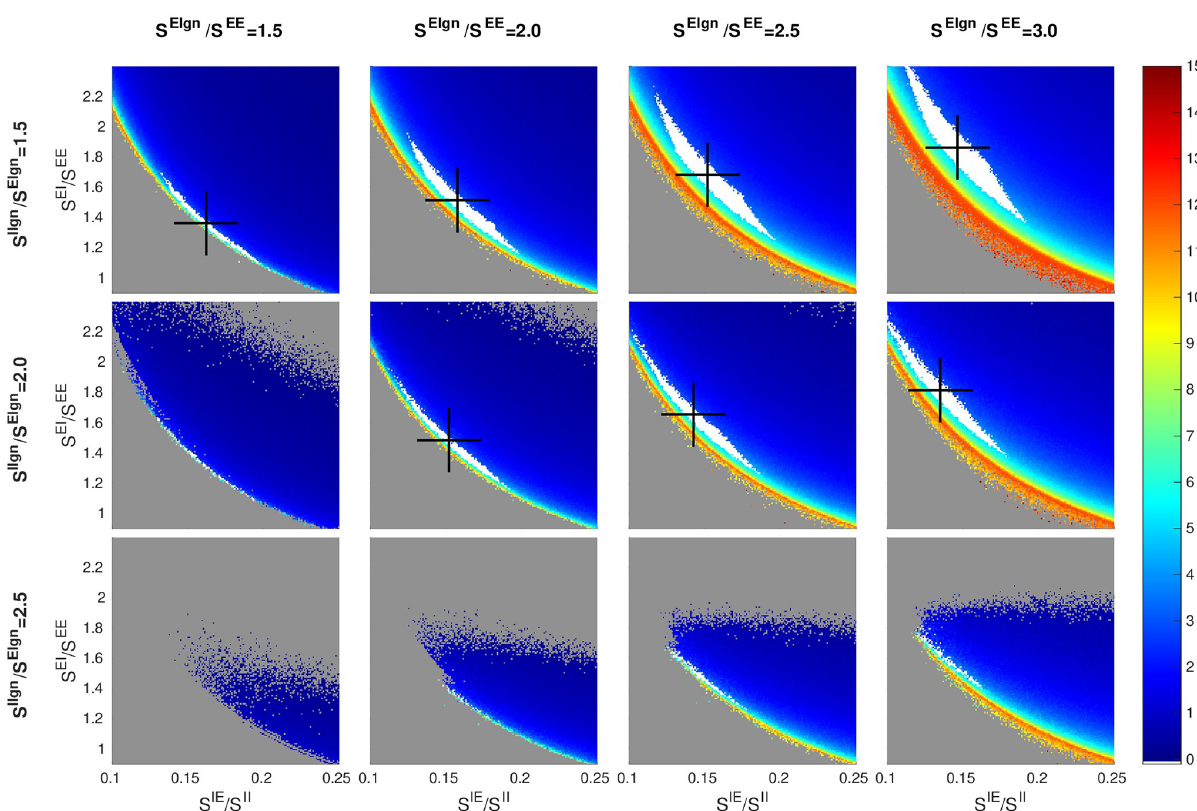
Fig 2. Dependence of firing rate and good area on LGN synaptic strengths. A 3 × 4 matrix of panels is shown: each row corresponds to a fixed value on an inhibition plane (color bar on the right); x and y -axes of S I lgn / E lgn and each column a fixed value of S E lgn / S EE . Each panel shows a heat map for f E are as in Fig 1. Good areas are in white, and their centers of mass marked by black crosses. The picture for S E lgn / S EE = 2 and S I lgn / E lgn = 2 (row 2, column 2) corresponds to the f rate map in Fig 1. Other free parameters are S EE = 0.024, S II = 0.12, and F I L6 = 3 × F E L6 . E